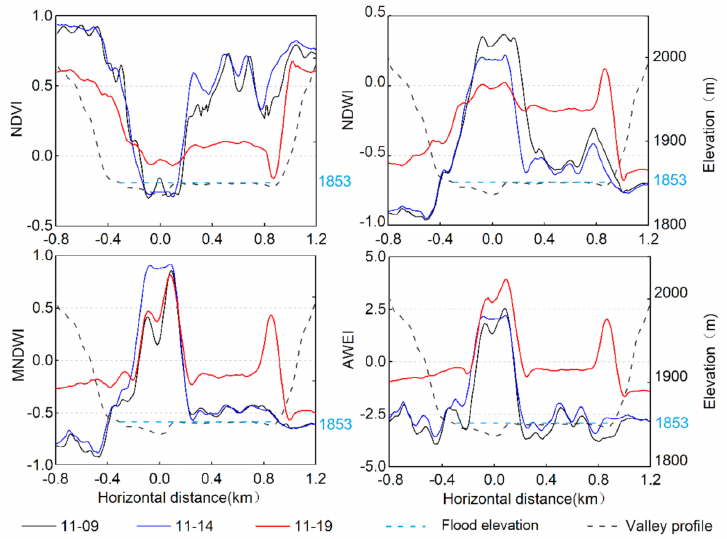
Figure 6. Time series of four spectral indices of profile